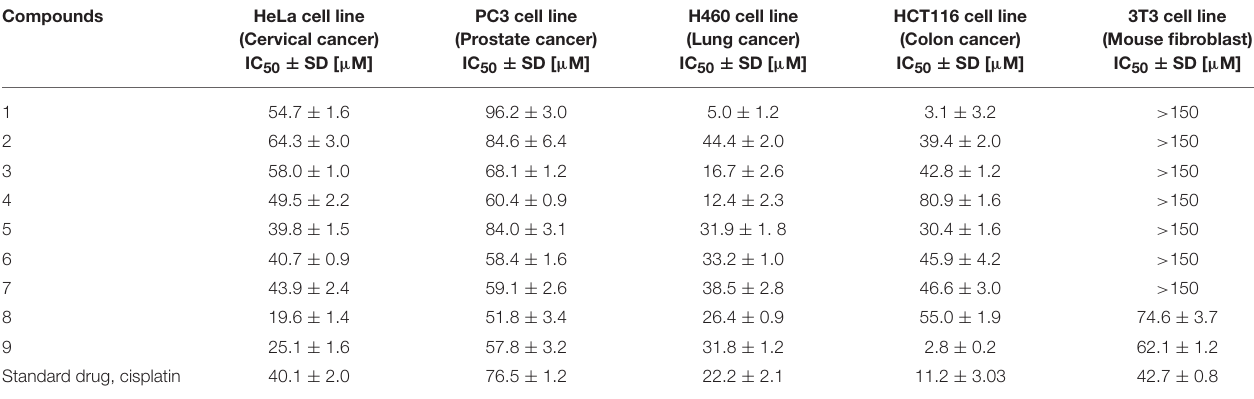
TABLE 5 | Cytotoxicity of compounds 1–9 against HeLa, PC3, H460, and HCT116 cancer, and 3T3 normal cell lines.